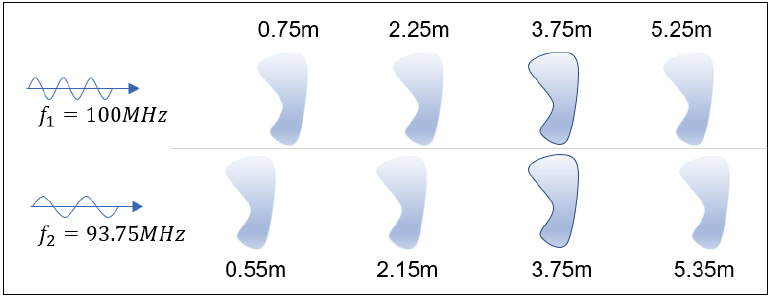
Figure 2. Sequential dual-frequency modulation scheme.